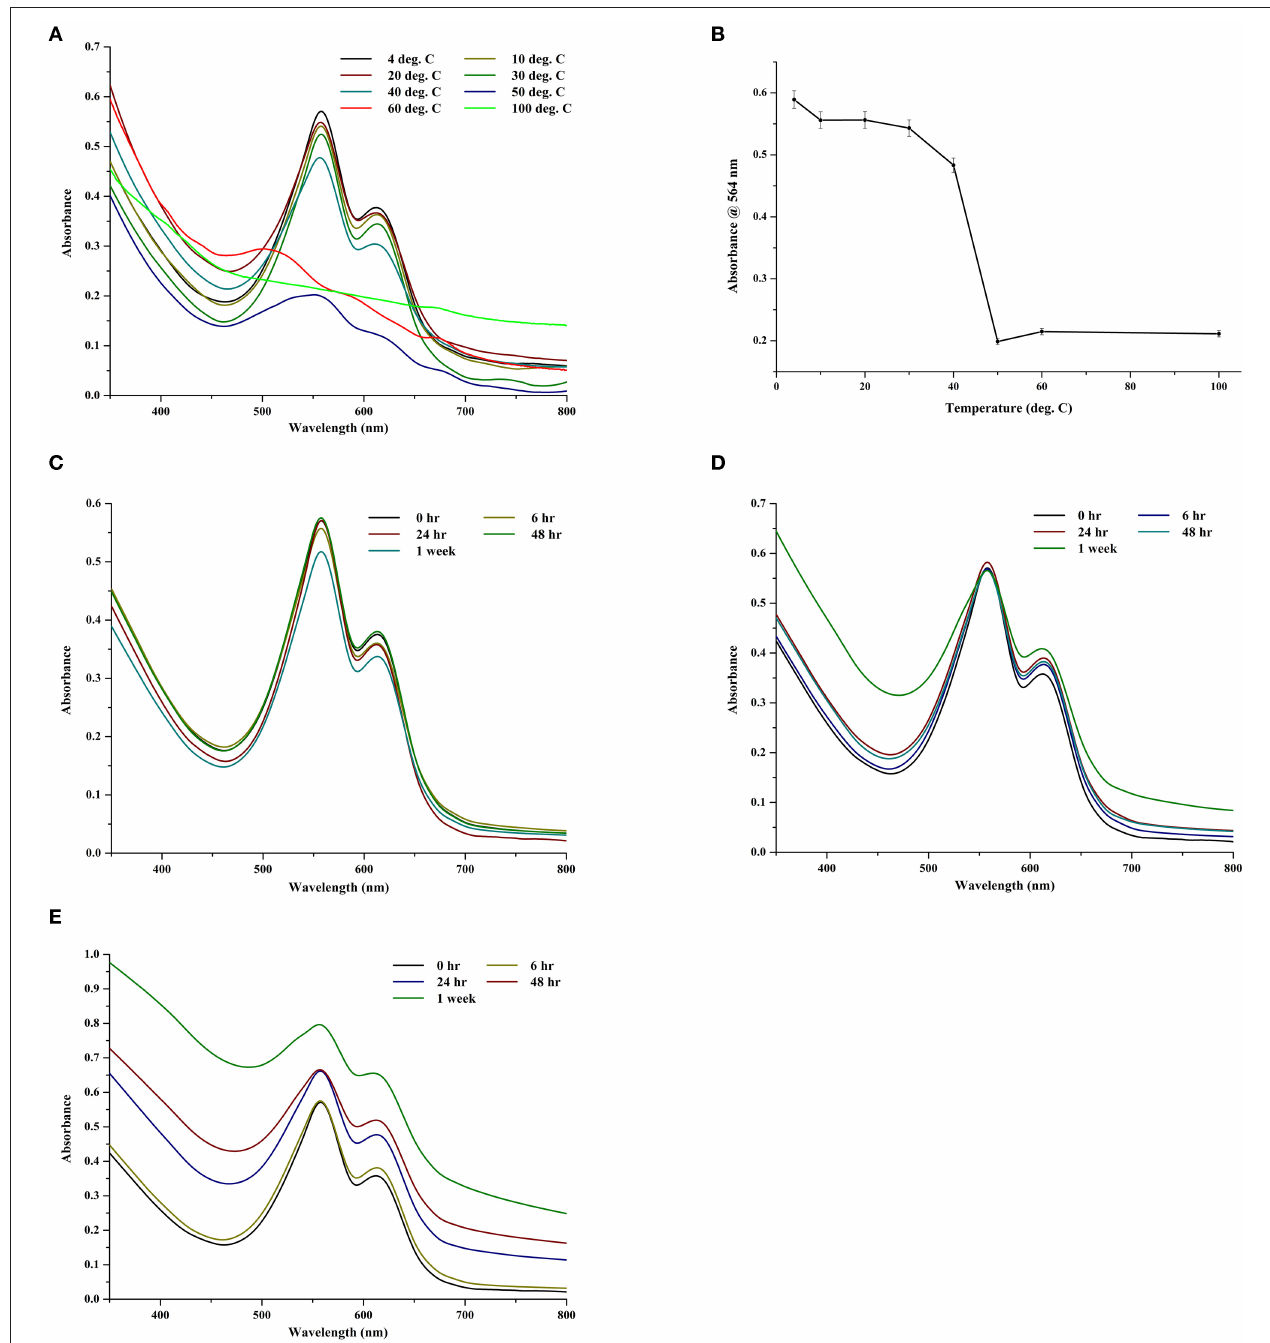
FIGURE 7 | (A) Effect of different temperatures on crude CPE extract. (B) Trace absorbance intensities at 564nm for CPE extract kept at different temperatures for 2h. (C) Effect of storage at − 64 ◦ C on crude CPE extract. (D) Effect of storage at 4 ◦ C on crude CPE extract. (E) Effect of storage at 10 ◦ C on crude CPE extract.